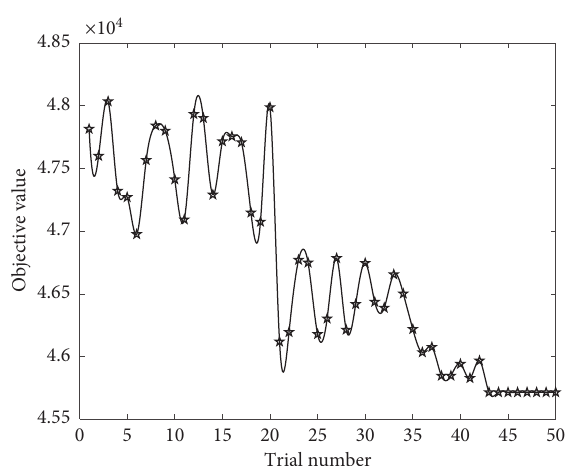
Figure 7: Performance curve of Q -learning scheduling